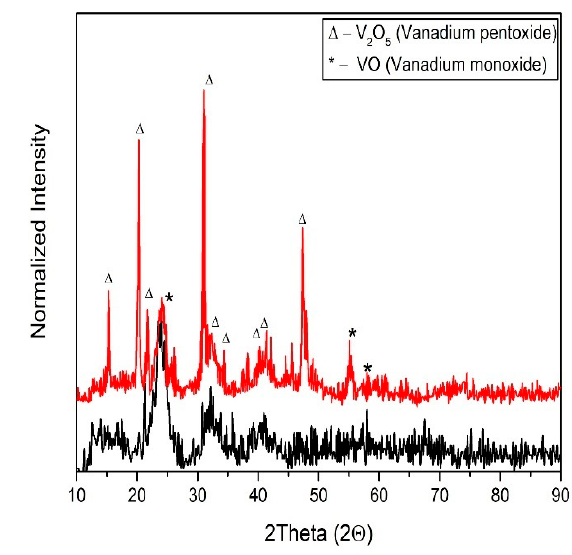
Figure 1. XRD patterns of V 2 O 5 at room temperature ( black ) and at 150 °C ( red ).